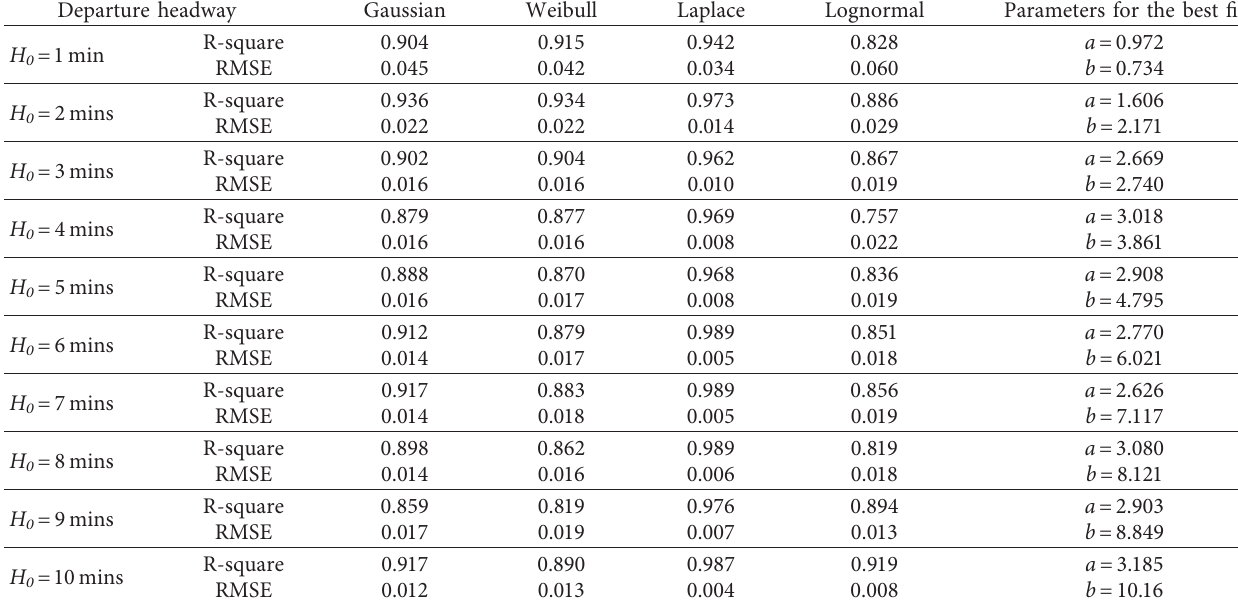
Table 6: Fitting results of bus arrival intervals.